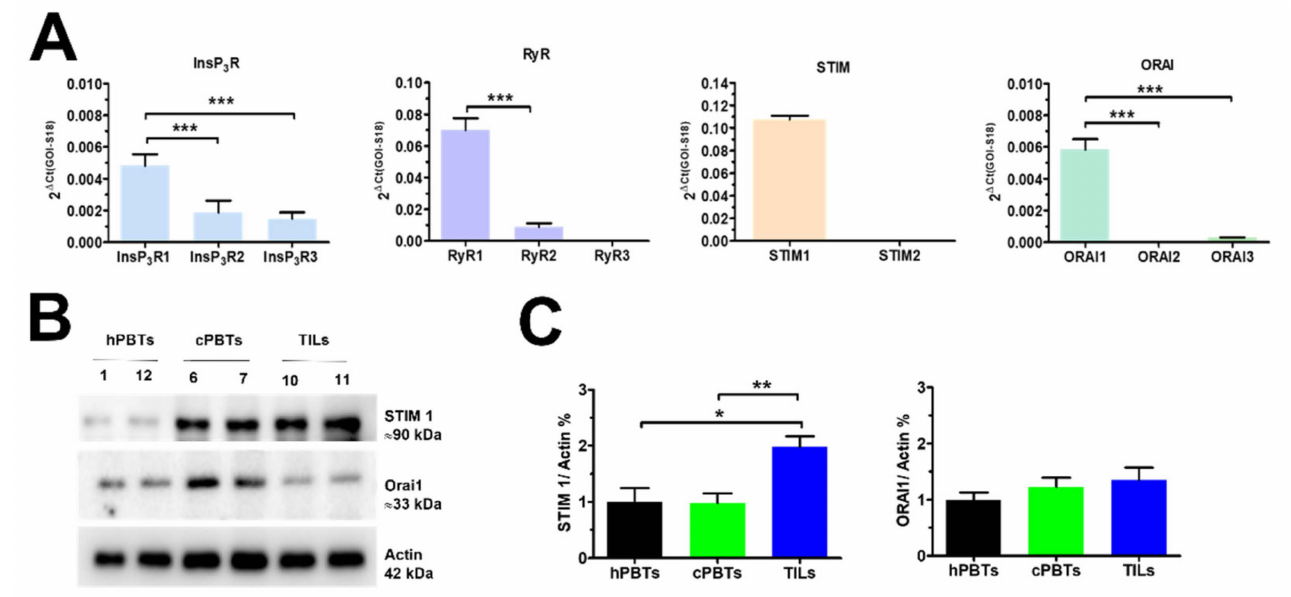
Figure 4. Molecular characterisation of the Ca 2+ -handling machinery in mCRC-derived T cells. ( A ) Transcriptomic profile of InsP 3 R, RyR, STIM, and Orai isoforms expressed in hPBTs. Data are calculated as 2 ∆ Ct(GOI-S18) and presented as mean ± SE from seven biological replicates from three donors for each condition (hPBTs, cPBTs and TILs). One-way ANOVA followed by the post hoc Bonferroni test: *** p < 0.001. ( B ) Expression of STIM1 and Orai1 proteins in hPBTs, cPBTs and TILs. Major bands of the expected molecular weight for each protein were observed. ( C ) Mean ± SE of the densitometric analysis of three different experiments, each carried out on a different donor. STIM1 and Orai1 protein bands were derived from the same experiment; thus, actin bands are common to the two proteins studied. One-way ANOVA followed by the post hoc Bonferroni test: * p < 0.05 and ** p < 0.01. Whole Western blot showing all bands in Figure